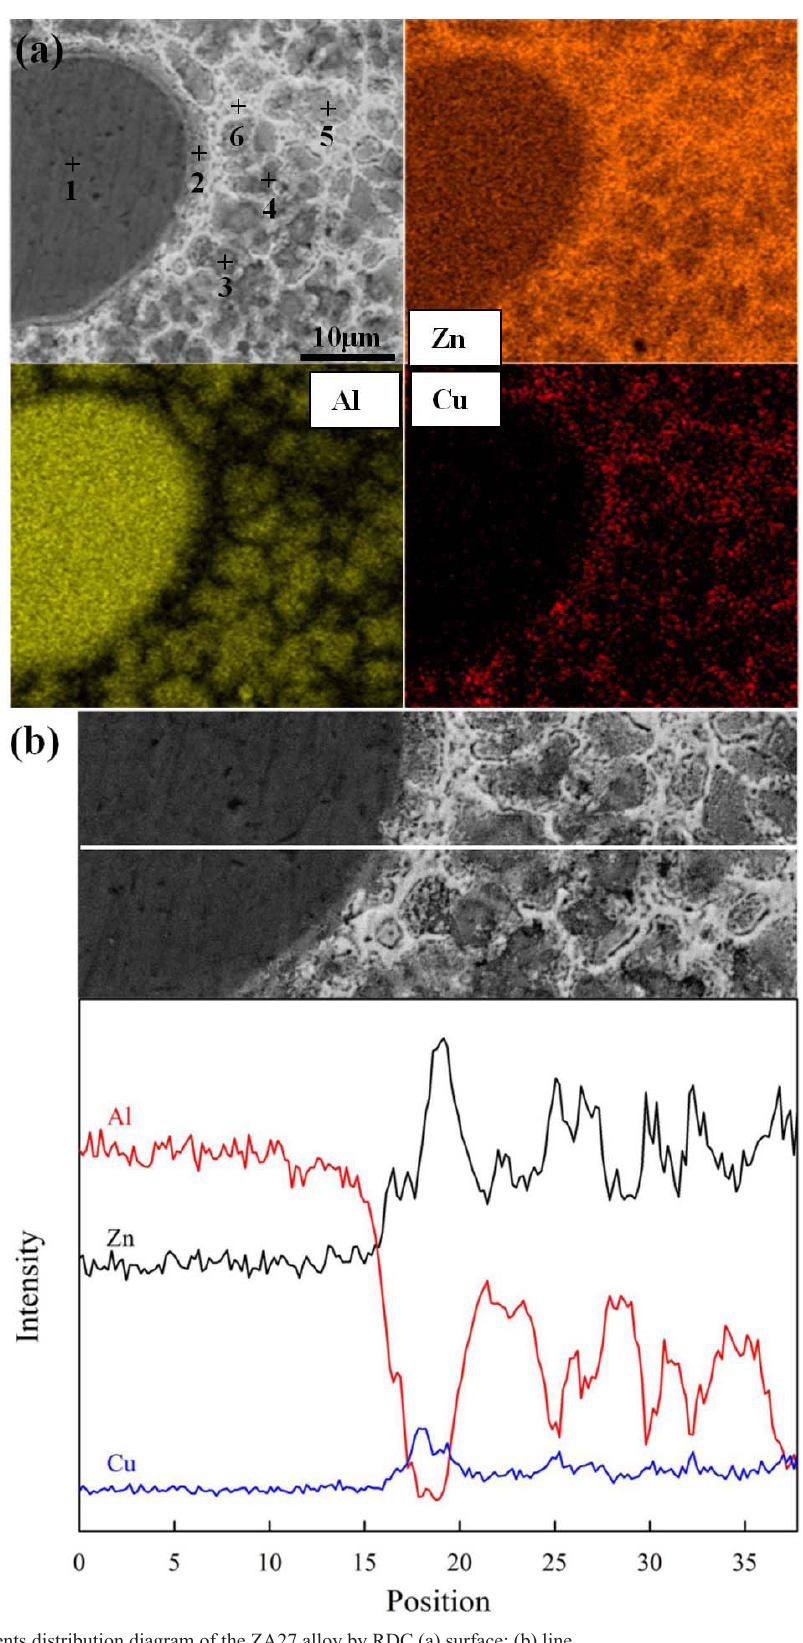
Figure 10. Elements distribution diagram of the ZA27 alloy by RDC (a) surface; (b)